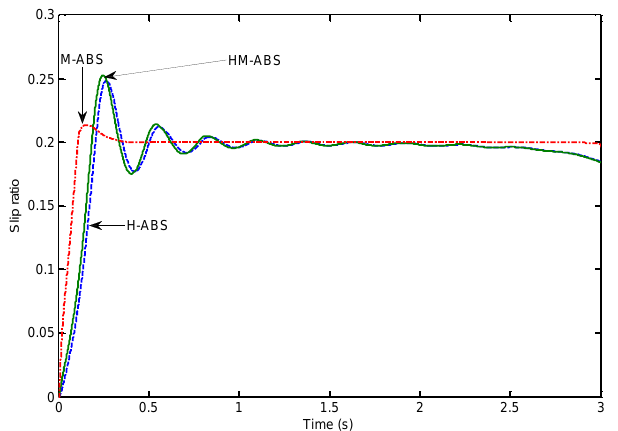
Figure 11. Comparison of slip ratio in three cases.